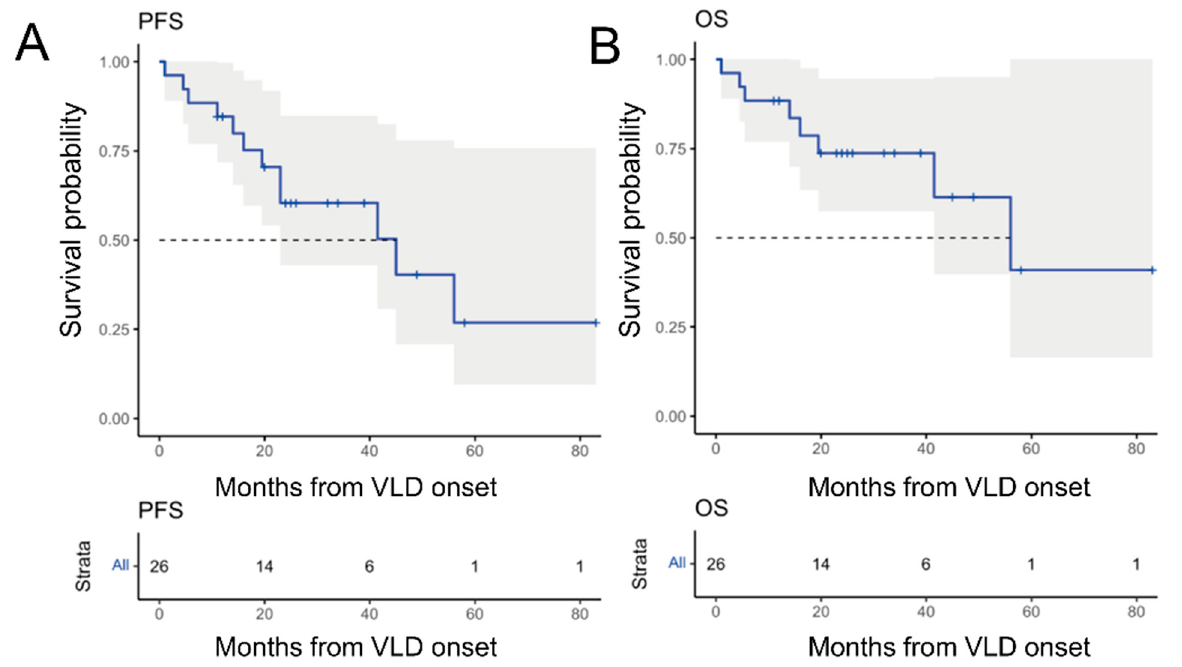
Figure 4. Kaplan–Meier survival analysis and prediction in 26 patients developing VLD after receiv- ing immunotherapy for metastatic melanoma. ( A ) Progression-free survival of all VLD patients with a 3-year PFS of 60.4% (95% confidence interval 43–84%). ( B ) OS of all VLD patients with a 3-year OS of 73.7% (95% confidence interval 57.5–94.6%).